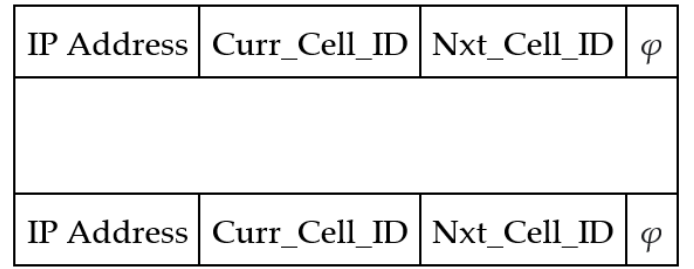
Figure 8. Global pheromone map and location information message format.